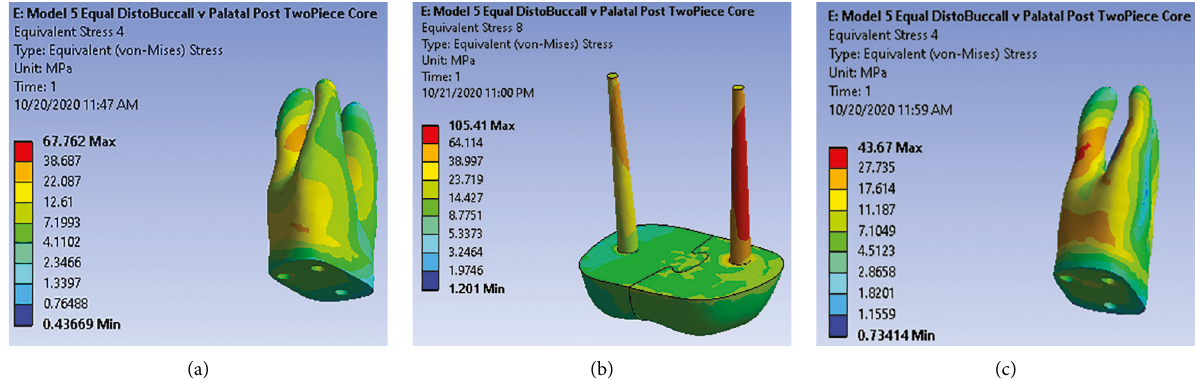
Figure 6: (a) Stress distribution pattern in dentin under 480 (N) along model 5. (b) Stress distribution pattern in post-core under 480 (N) along model 5. (c) Stress distribution pattern in dentin under 240 (N) along model 5.